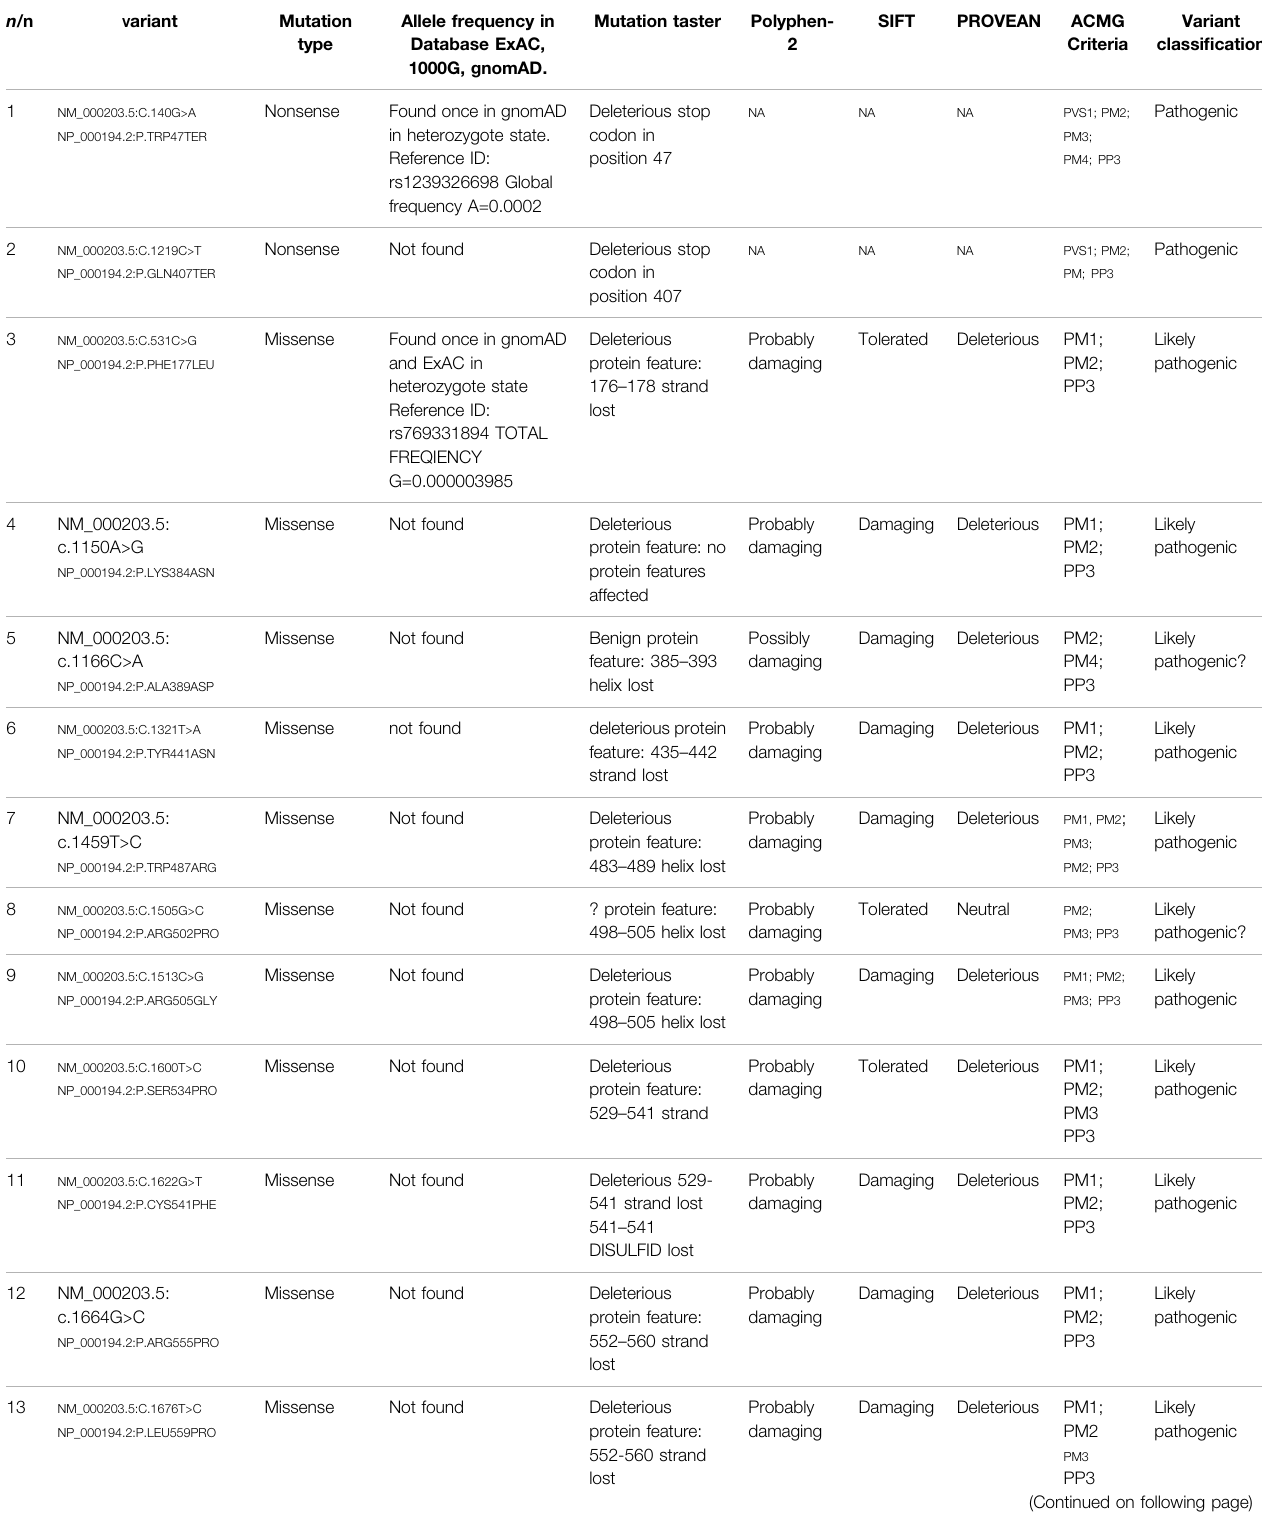
TABLE 3 | The annotation of the novel mutations of the IDUA